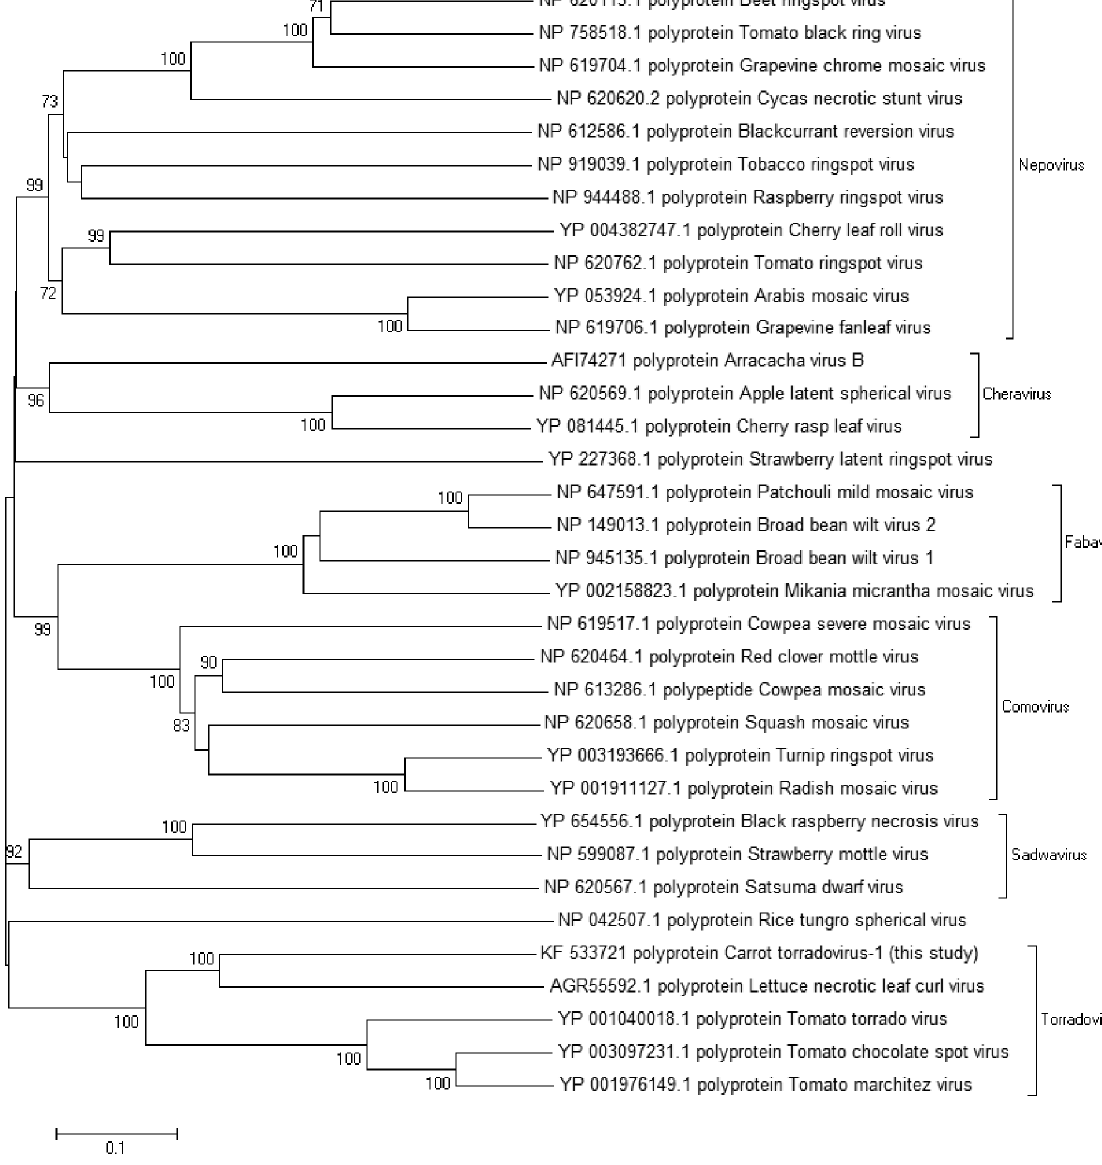
Figure 5. Bootstrapped neighbour joining tree of RNA2 polyproteins from viruses within the family Secoviridae constructed with MEGA5 using 500